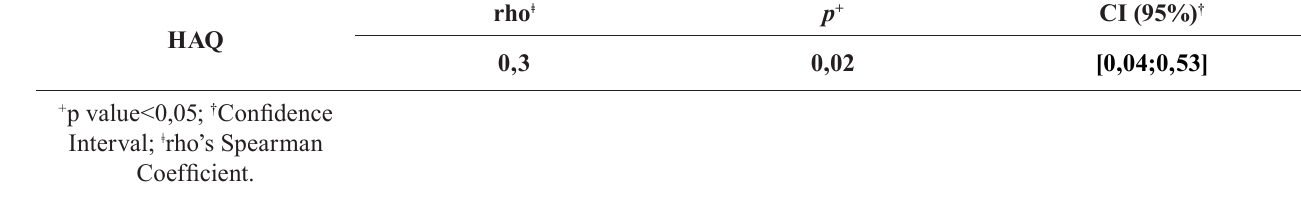
TABLE II - Correlation of DAS28 score with HAQ scores